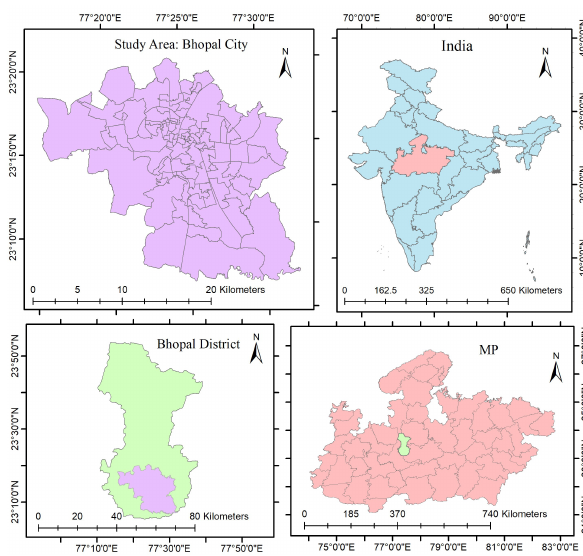
Figure 1. Location of the study area of Bhopal municipal Corporation